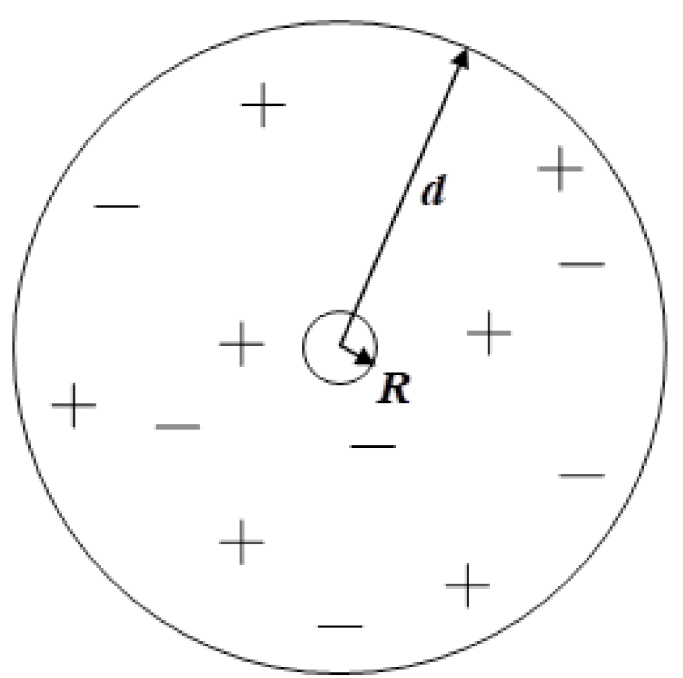
Figure 1. Spherical, electrically neutral volume with radius d for calculation of potential of the central charged particle with radius